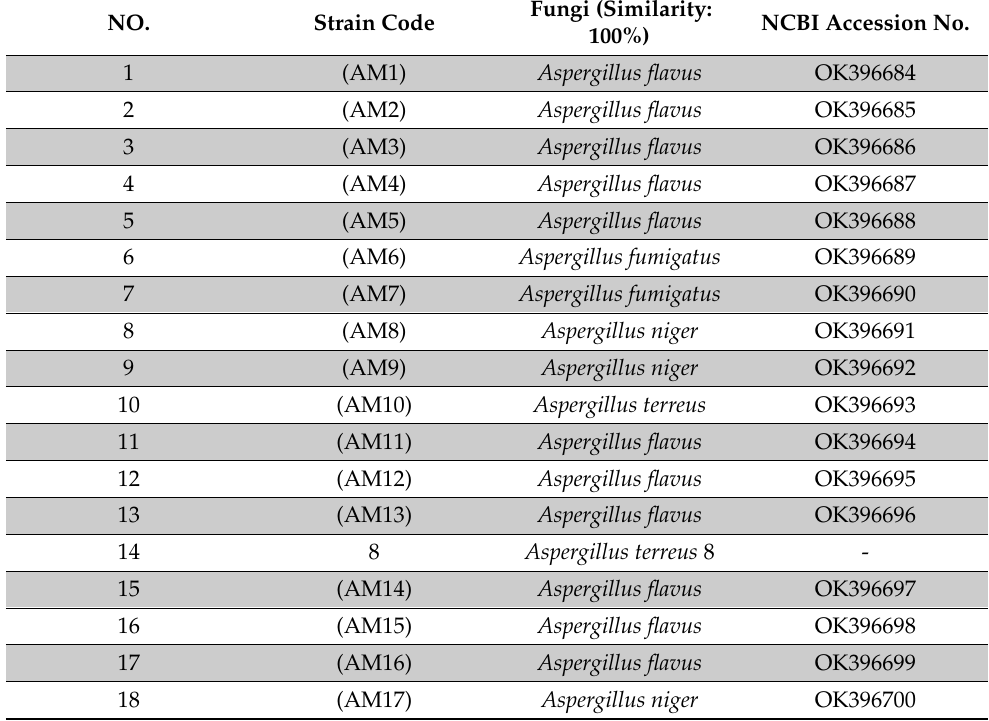
Table 1. List of fungi isolated and their NCBI accession numbers. NO. Strain Code